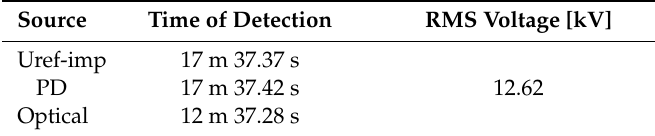
Table 2. Time and voltage of detected inception from the different data sources.